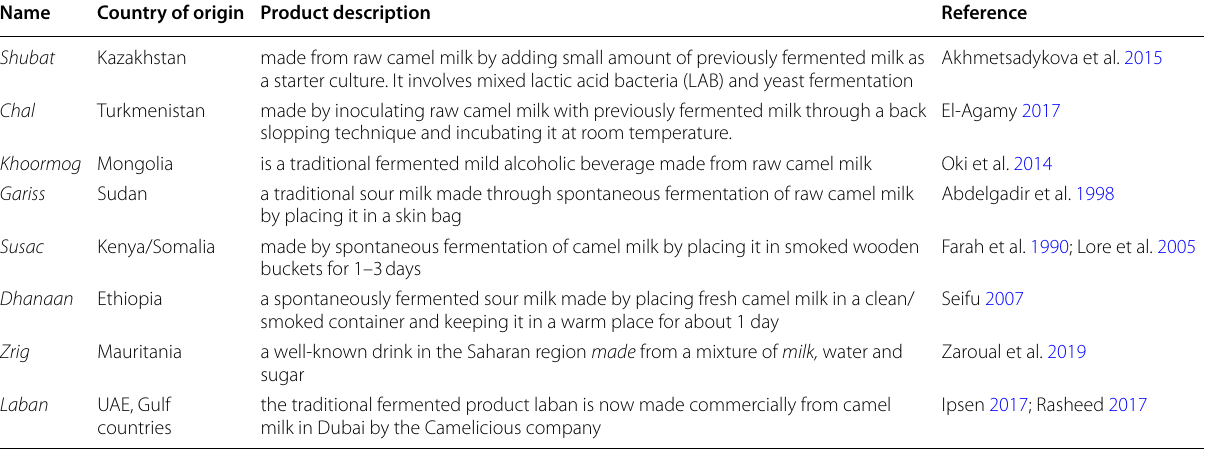
Table 2 Common traditional fermented camel milk products produced around the world